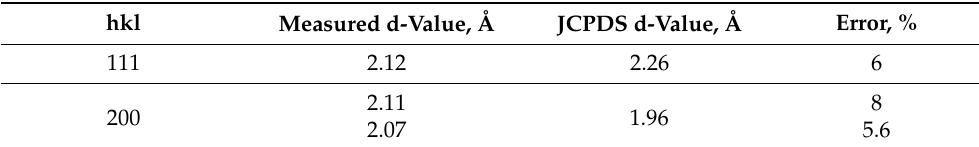
Figure 9 . ( a ) . TEM images, nanoparticles’ size distribution histograms and FFT images of the Pt/Al 2 O 3 catalyst. ( b ) . TEM images, nanoparticles’ size distribution histograms and FFT images of the Pt/Mg-Al 2 O 3 catalyst. ( c ) . TEM images, nanoparticles’ size distribution histograms and FFT images of the Pt/Zn-Al 2 O 3 catalyst. Table 5. d-Spacing values from fast Fourier transform (FFT) measurements and Joint Committee on Powder Diffraction Standards